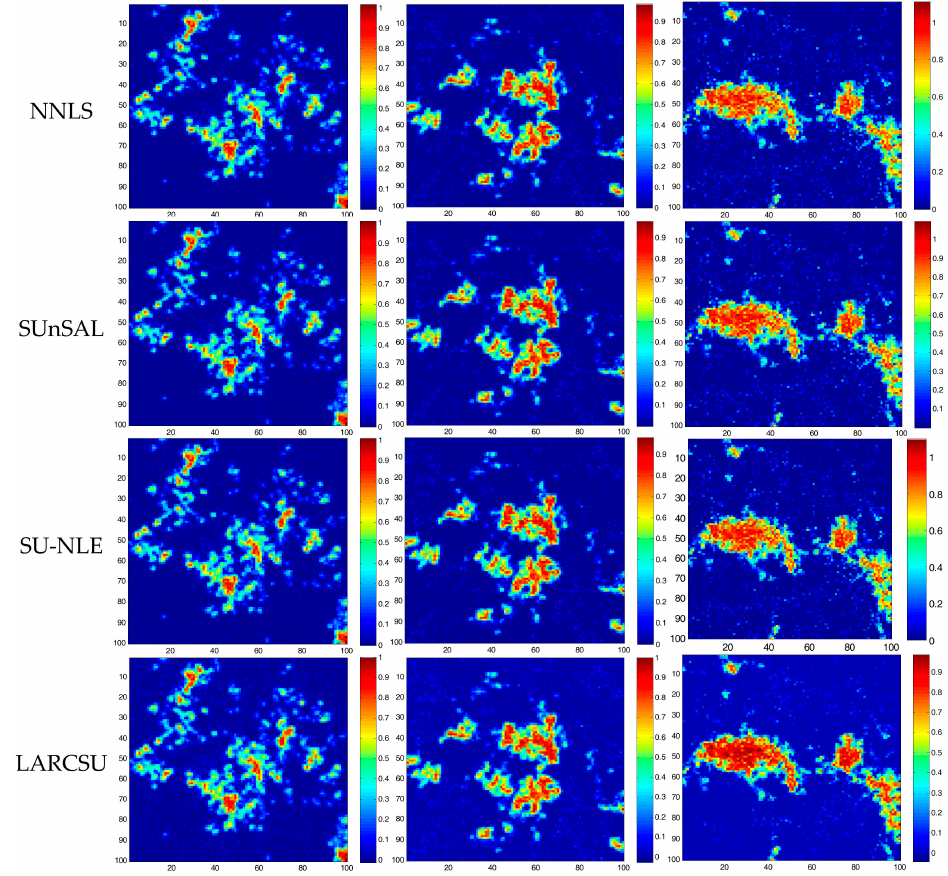
Figure 8. Estimated abundances of the endmembers for